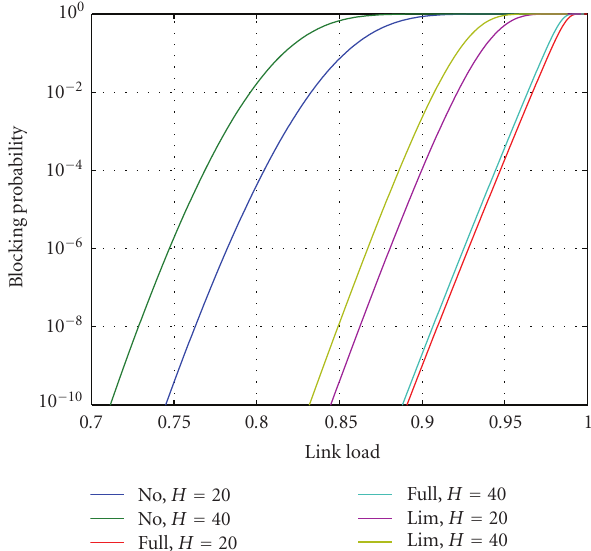
Figure 3: The blocking probability P b = f ( ρ ), W = 15, k = 3, and F =